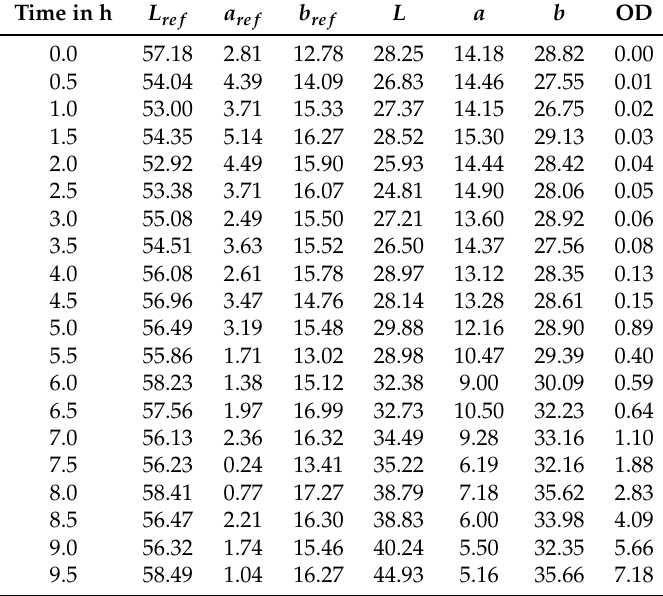
Table 2. Measurements 241 to 260 of CIELAB colour components and optical density (OD) values. Time in